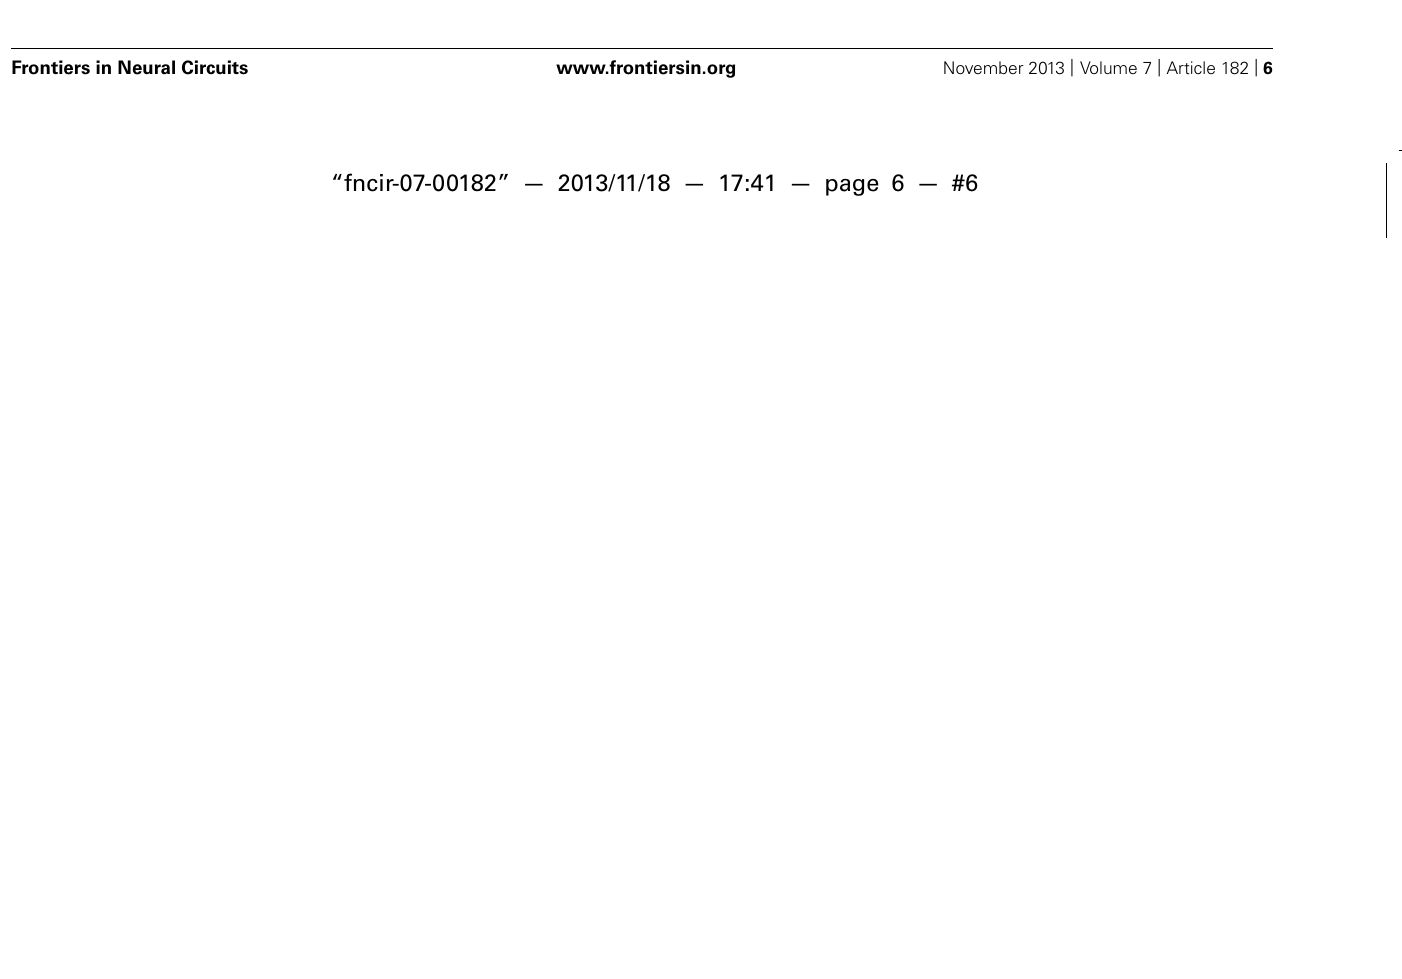
relay center coupling eye motion and body posture. The most caudal vestibulospinal neurons originate bilaterally from the DO with predominance for ipsilateral projections. The populations of both ipsi- and contralaterally descending vestibulospinal neurons between r4-6 are morphologically rather heterogeneous and con- vey semicircular canal and otolith signals. The central location